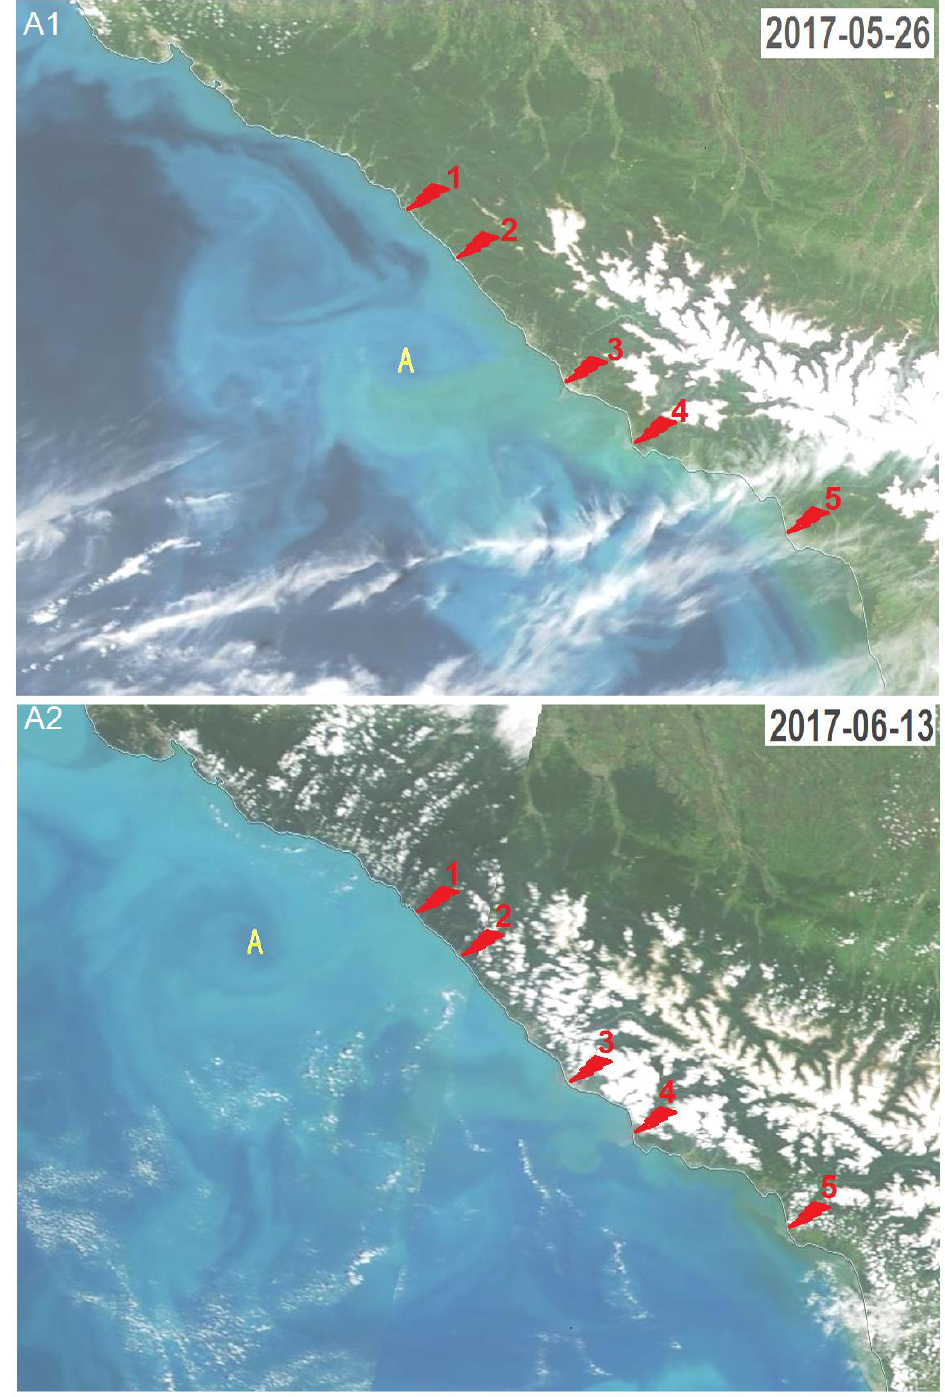
Figure 9. Successive MODIS Terra/Aqua satellite images illustrating the capture of the chlorophyll-a rich river plume water by the Caucasian anticyclonic eddy on 26 May 2017 ( A1 ); and dragging it by the eddy along the coast on 13 June 2017 ( A2 ). The center of the eddy is marked by AC. River mouth locations are numbered as in the panel ‘day 31 0 ’ of Figure 8. By 13 June 2017, the eddy was considerably extended, so its core size reached about 60 km and concentration of chlorophyll-a inside the eddy visually was noticeably de- creased. The chlorophyll-a rich area along the shore off the Iskuria – Pitsunda region was